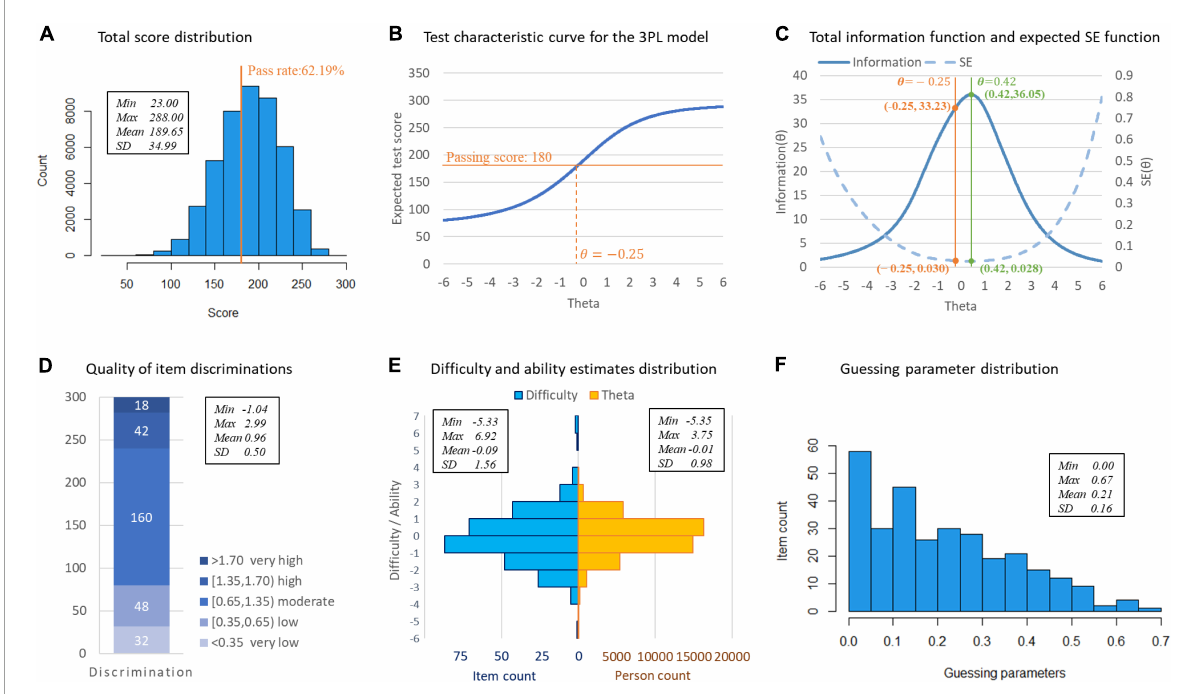
FIGURE2 Statistical and item response theory (IRT) analysis results of Standardized Competence Test for Clinical Medicine Undergraduates (SCTCMU). (A) Total score distribution. (B) Test characteristic curve for the 3PL model. (C) Total information function and expected SE function. (D) Quality of item discriminations. (E) Difficulty and ability estimates distribution. (F) Guessing parameter distribution.